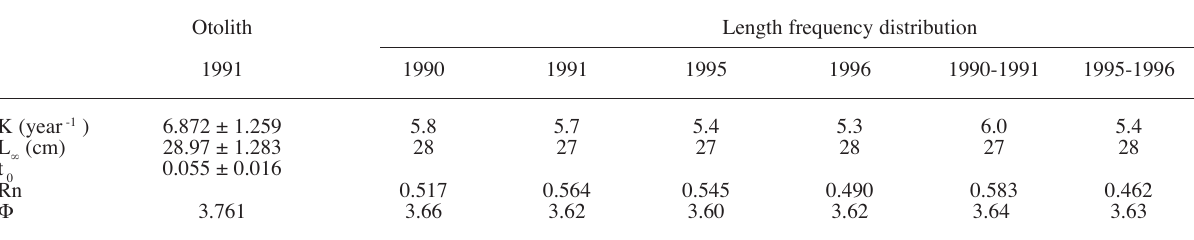
F IG . 6. – Relationship between fork length and estimated age for all specimens of Naucrates ductor studied in 1990 and 1991, and the von Bertalanffy growth curve fitted using data from the age determination of the 1991 summer cohort. T ABLE 4. – Estimated parameters of the von Bertalanffy equation (± standard error). Results based on the otolith readings of specimens caught in 1991 (summer cohort) and on the length frequency distribution for 1990, 1991, 1995 and 1996. Φ : growth performance index (Munro and Pauly,